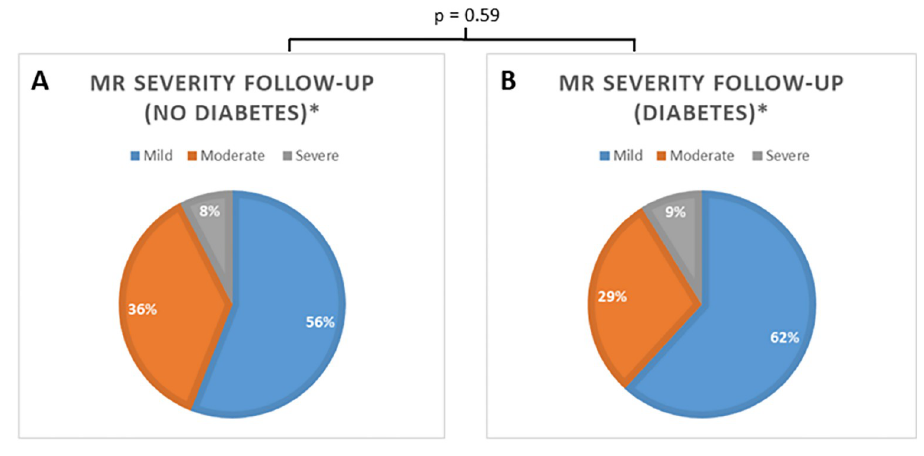
Fig 1. Mitral regurgitation (MR) severity grade at one-year follow-up. The left panel (A) shows MR severity grade in patients without diabetes and the right panel (B) in patients with diabetes mellitus.